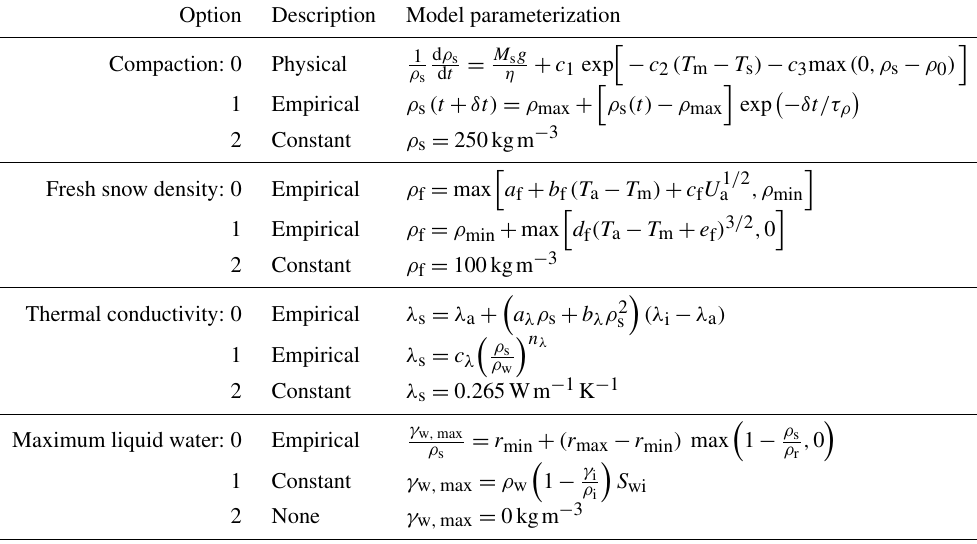
Table 1. Equations for options governing the representation of processes in the JIM model